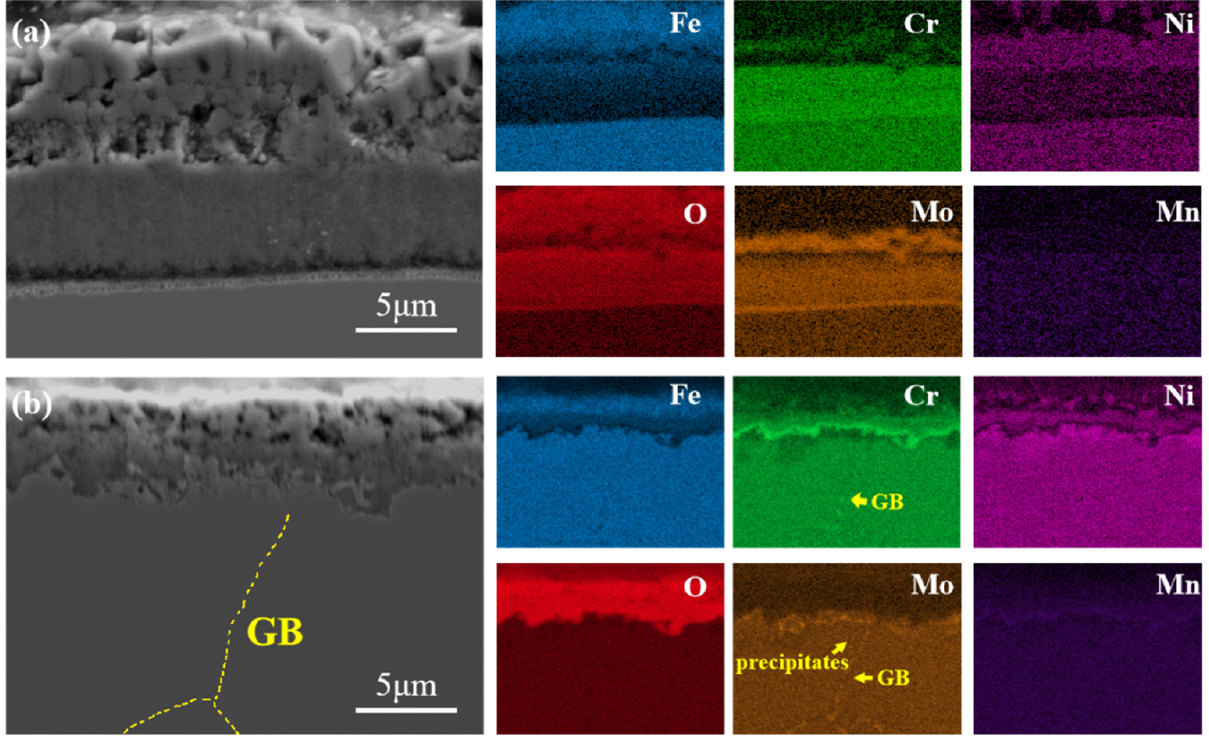
Figure 7. SEM cross – section morphologies and EDS analysis results of 254SMO – 0B ( a ) and 254SMO – Figure 7. SEM cross-section morphologies and EDS analysis results of 254SMO–0B ( a ) and 254SMO– 40B ( b ) after oxidation at 900 °C for 30min. 40B ( b ) after oxidation at 900 ◦ C for 30